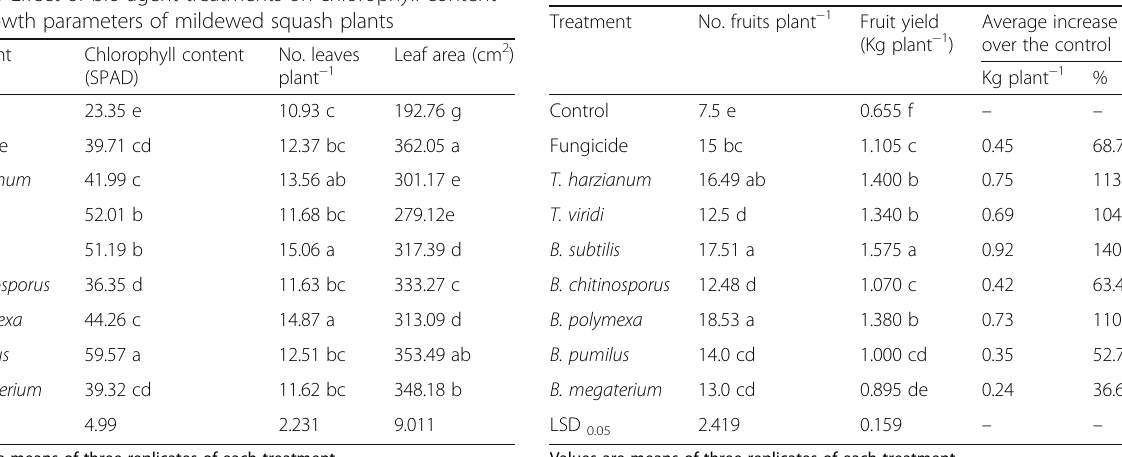
Table 4 Influence of biological agents on yield parameters of squash plants